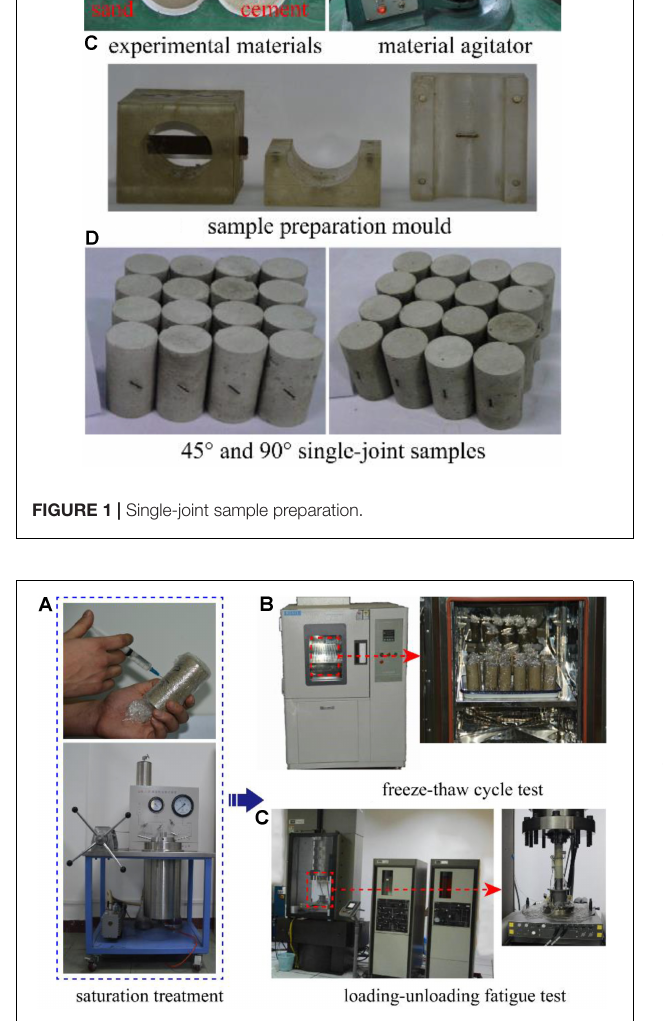
FIGURE 2 | Test equipment and procedure.